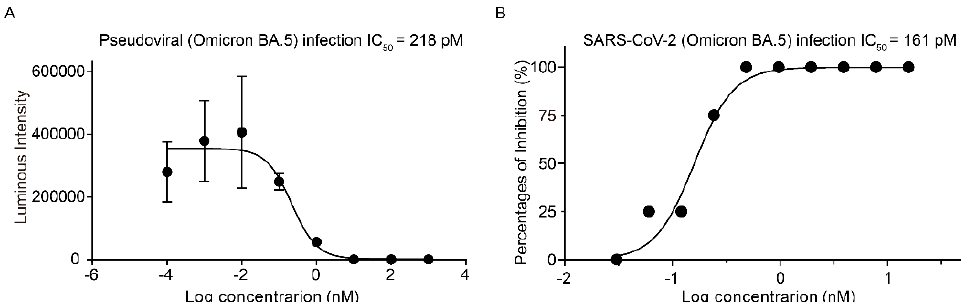
Figure 2. The inhibitory effect of Kansetin on Omicron BA.5 strain. ( A ) Kansetin neutralizes pseu- dovirus infection of 293T-ACE2 cells. Data are mean ± SD ( n = 6 per group). The buffer was used as a blank control for the experiment and showed no inhibitory effect on pseudovirus-infected cells.